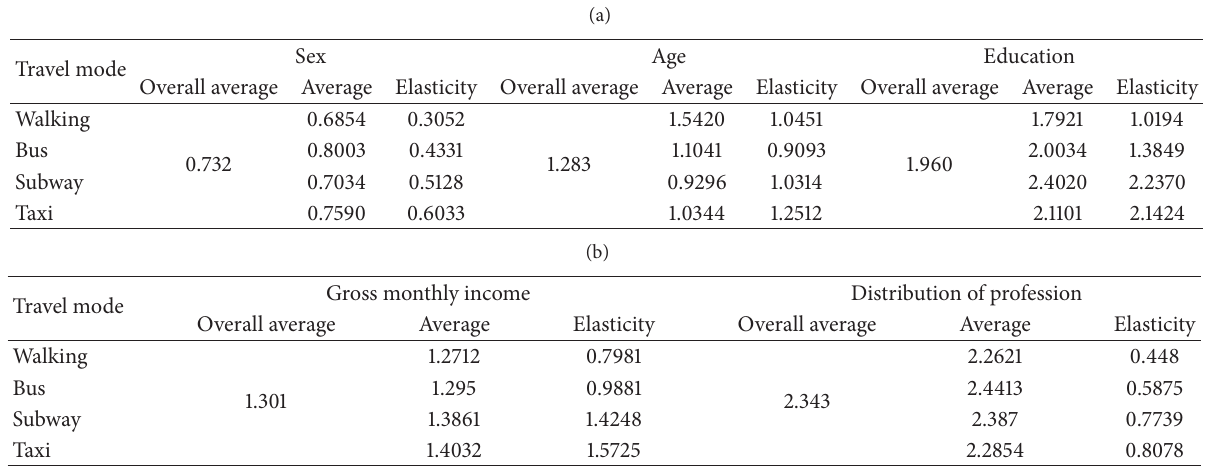
Table 5: Average value and elasticity value of individual